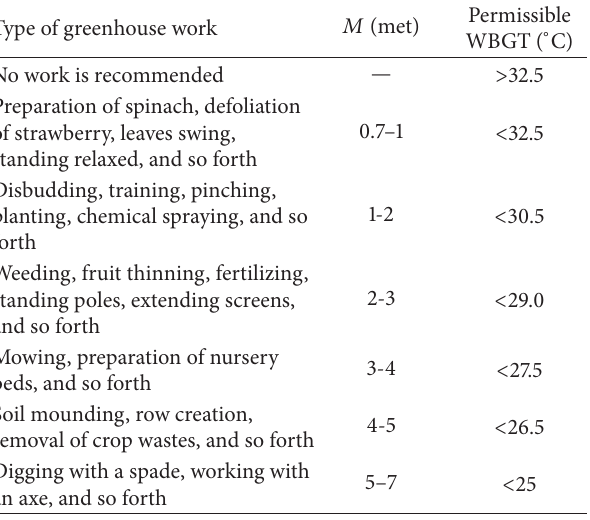
Table 1: Various types of greenhouse work and the corresponding highest permissible WBGT